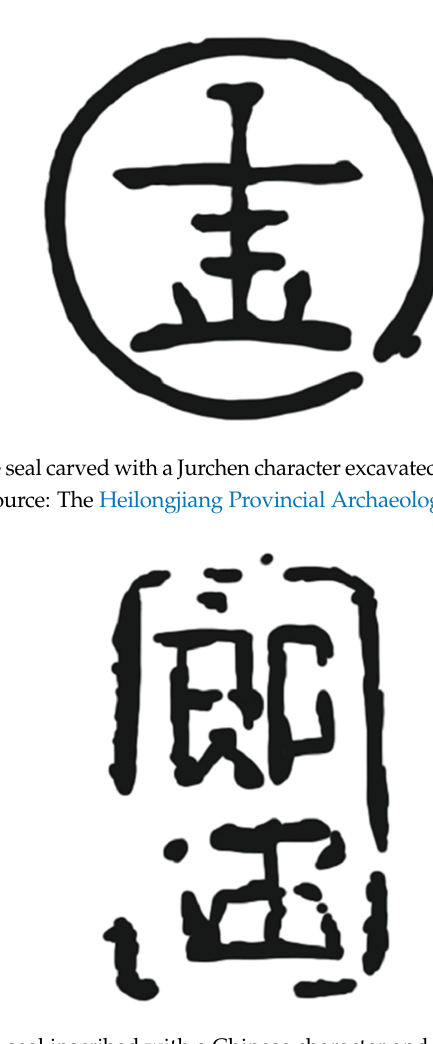
Figure 35. A stone bronze seal inscribed with a Chinese character and an ethnic character excavated in Zhongxing City, Heilongjiang. The Jin Dynasty. Picture source: The Heilongjiang Provincial Archaeological Research Team (1977), p. 45.